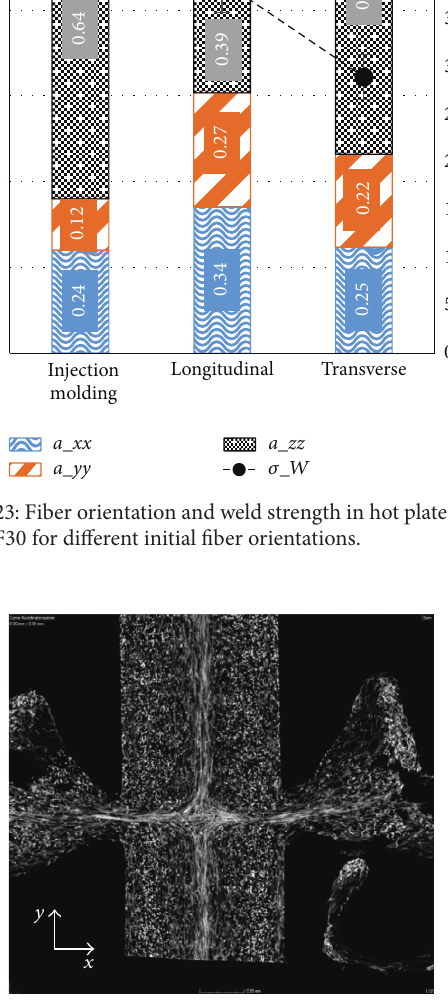
Figure 24: CT picture of the weld of PA-GF30EF with initial fiber orientation being longitudinal to the joining direction (DP I).